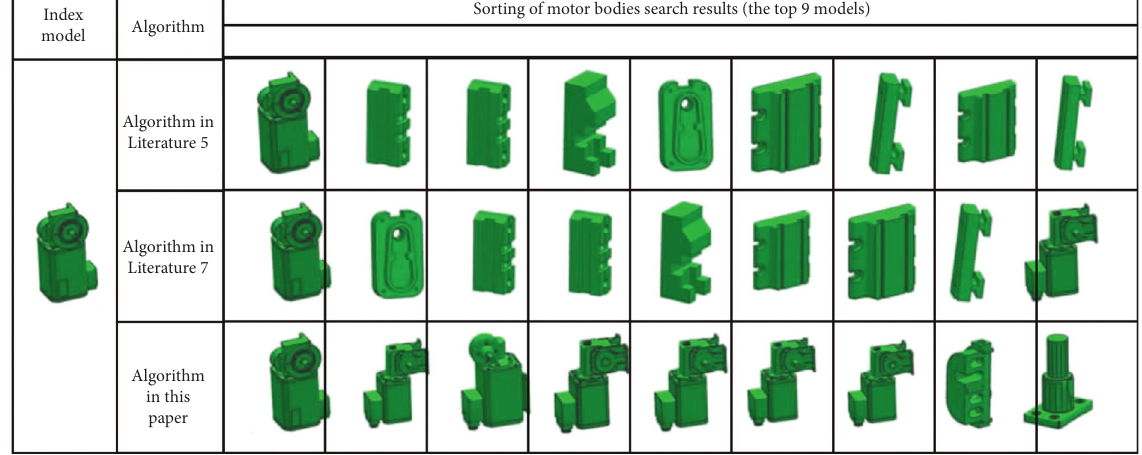
Figure 9: Search results of Motor Bodies category in ESB.